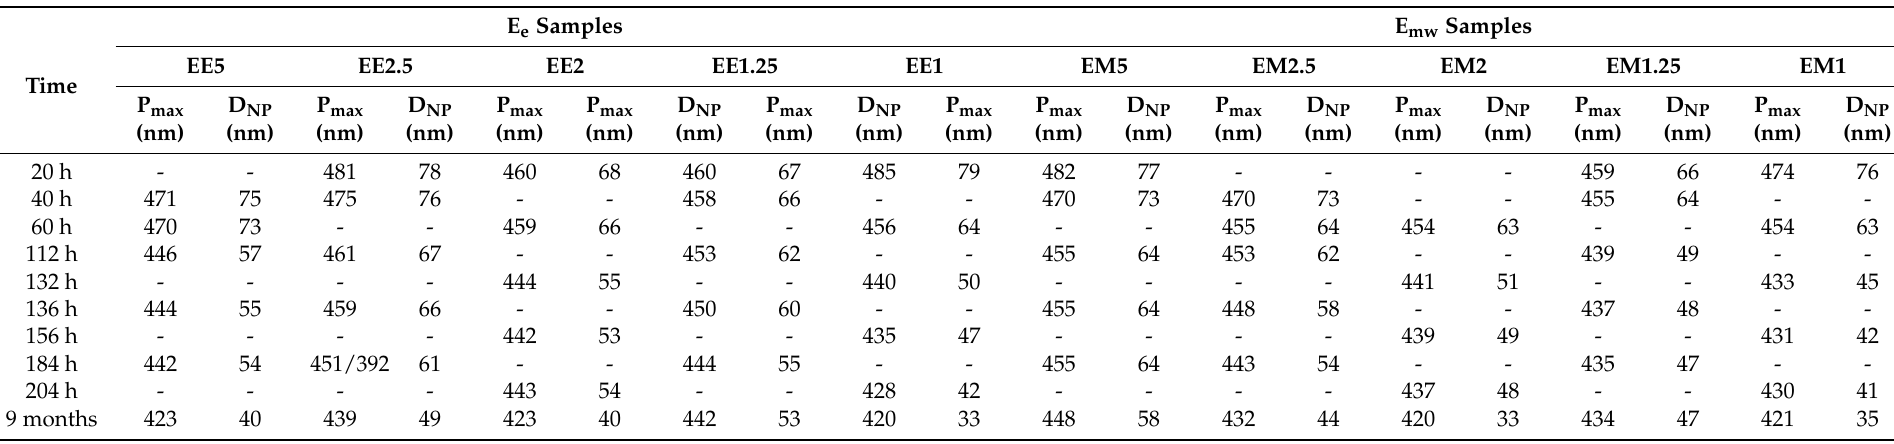
Table 3. Evaluation of particle formation using Echinacea purpurea L. extracts by UV-Vis spectrometry as a function of reaction time (P max —characteristic